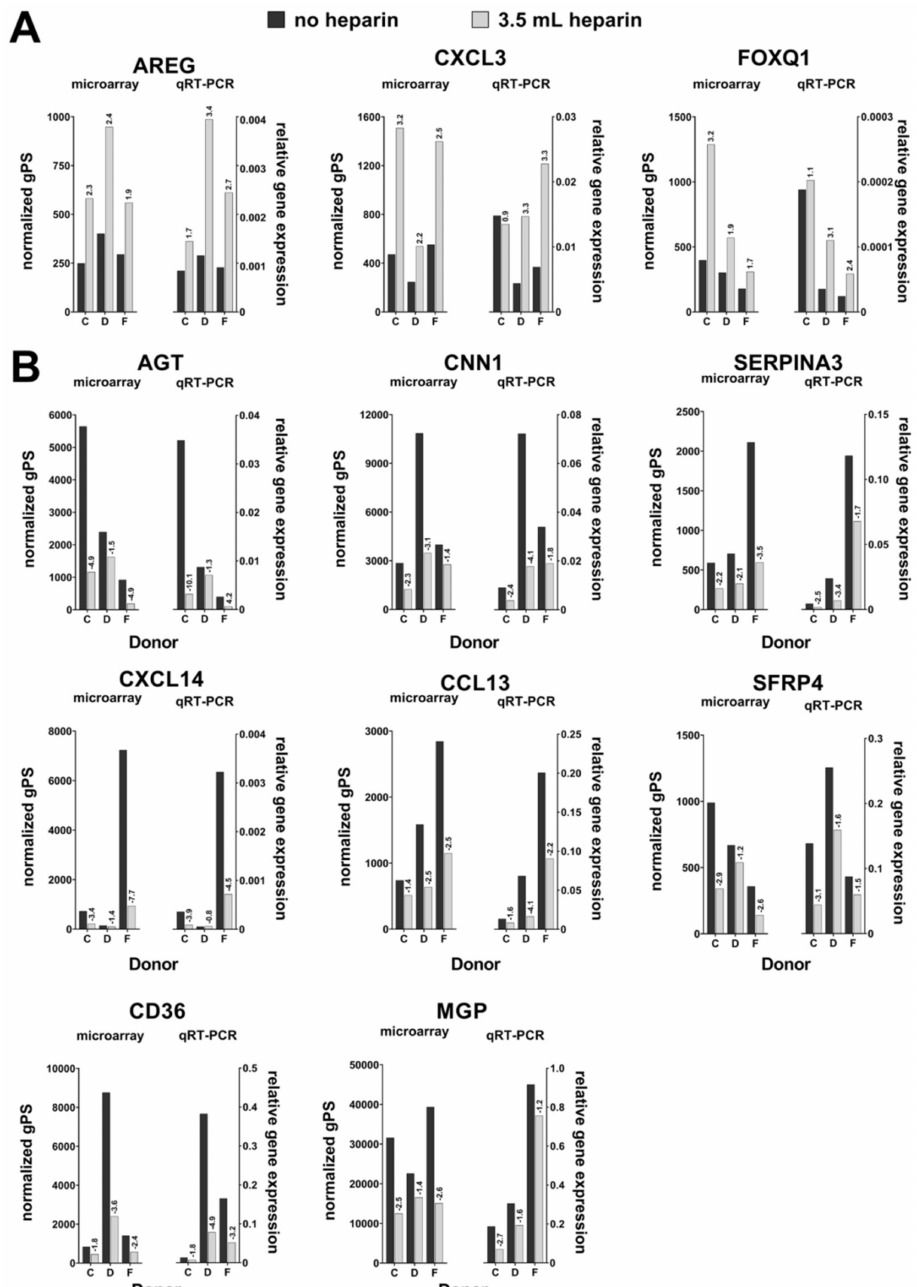
Figure 8. Results of comparative microarray-based transcriptome versus qRT-PCR analysis of cells from donors C, D and F. Normalized green processed signals (gPS) and qRT-PCR-based relative gene expression levels (2 − ∆ Ct ) of all eleven genes identified as regulated by heparin are depicted. ( A ) Relative gene expression changes of upregulated genes. ( B ) Expression changes of downregulated genes. In cases with more than one available microarray probe per gene, values of that probe with the highest mean gPS value across all tested conditions was chosen for this